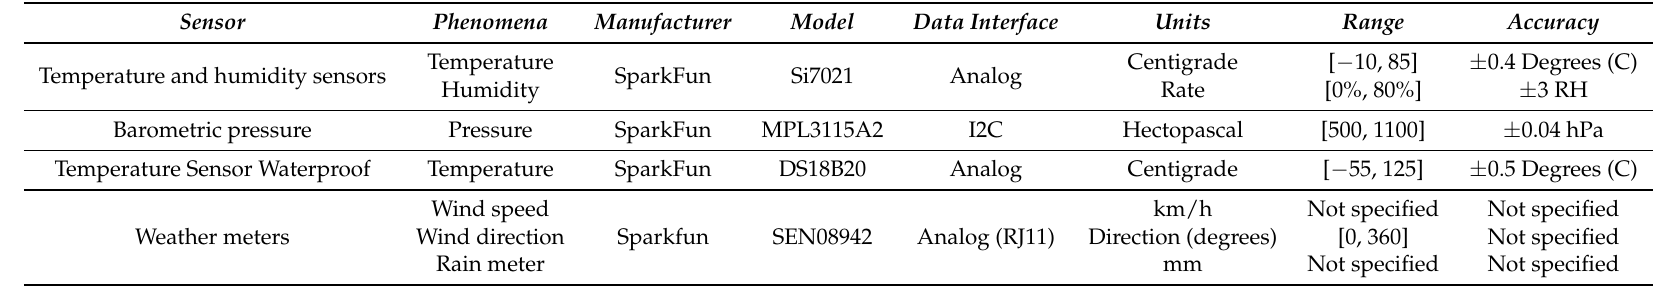
Table 3. Details of the included Sensors